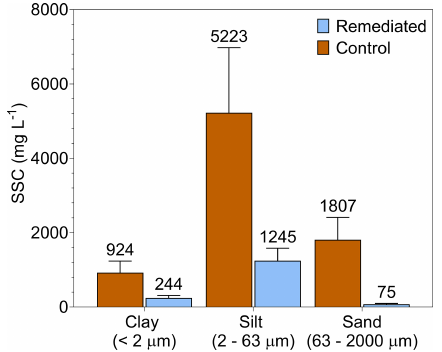
Figure 3. Median SSC by sediment size class for PASS samples collected from the control (brown) and remediated (blue) gullies during the 2017–2018 and 2018–2019 wet seasons. Error bars rep- resent the sample standard deviation. Autosampler and RS sampler SSC by PSD are included in Sect. S7.